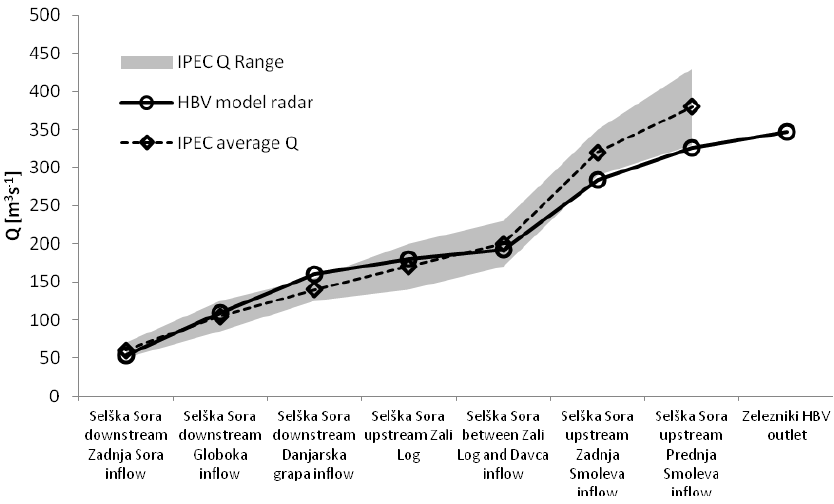
Fig. 10. Modelled vs IPEC estimated peak discharges. Dash line is the survey estimated peak discharge and the solid line is the modelled peak discharge. The gray area represents the uncertainty range of IPEC peak discharge Figure 10: Modeled vs IPEC estimated peak discharges. Dash line is the survey estimated 3 peak discharge and the solid line is the modeled peak discharge. The gray area represents the 4 uncertainty range of IPEC peak discharge estimations. 5